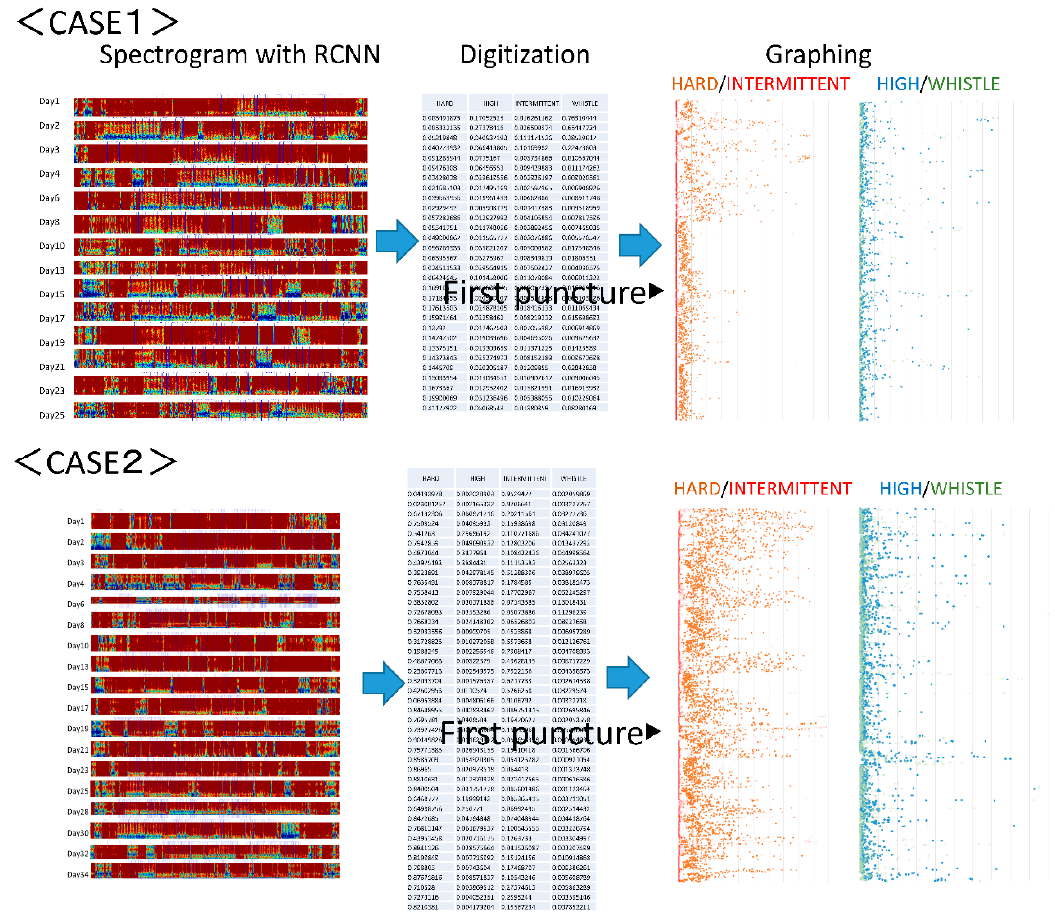
Figure 5. Arteriovenous fistula analysis sound of two cases. The first case is arteriovenous fistula construction resulting from acute renal failure. The puncture began two weeks later. Immediately after creation, the initial sound had a small hardness component due to the influence of a vasospasm. In the second case, an arteriovenous fistula was constructed after a long history of diabetes. The puncture began three weeks later. In both cases, it was observed that the arteriovenous fistula sound was hard at the beginning, even when the arteriovenous fistula sound developed, and that the ratio of random intermittent and harmonic sounds due to the start of puncturing increased.